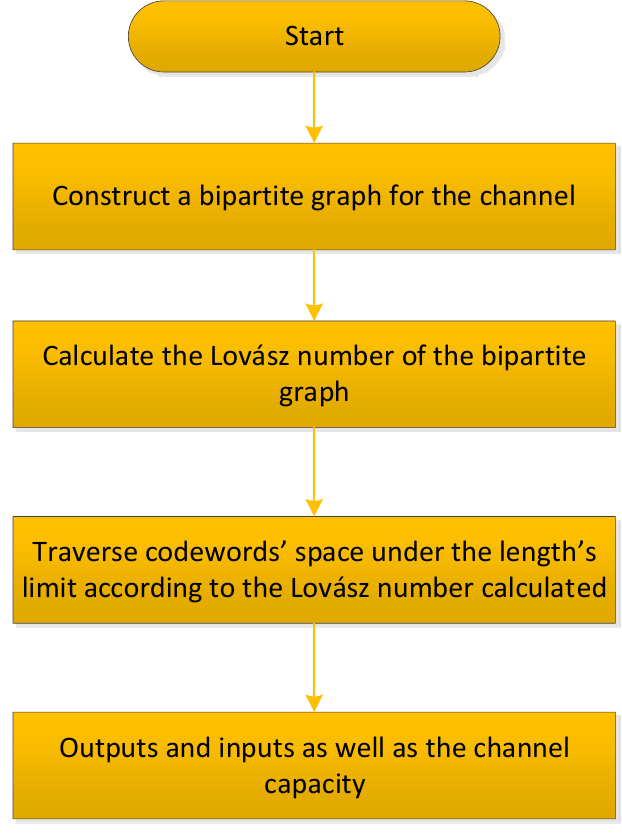
Figure 2. Flowchart of classical zero-error coding.